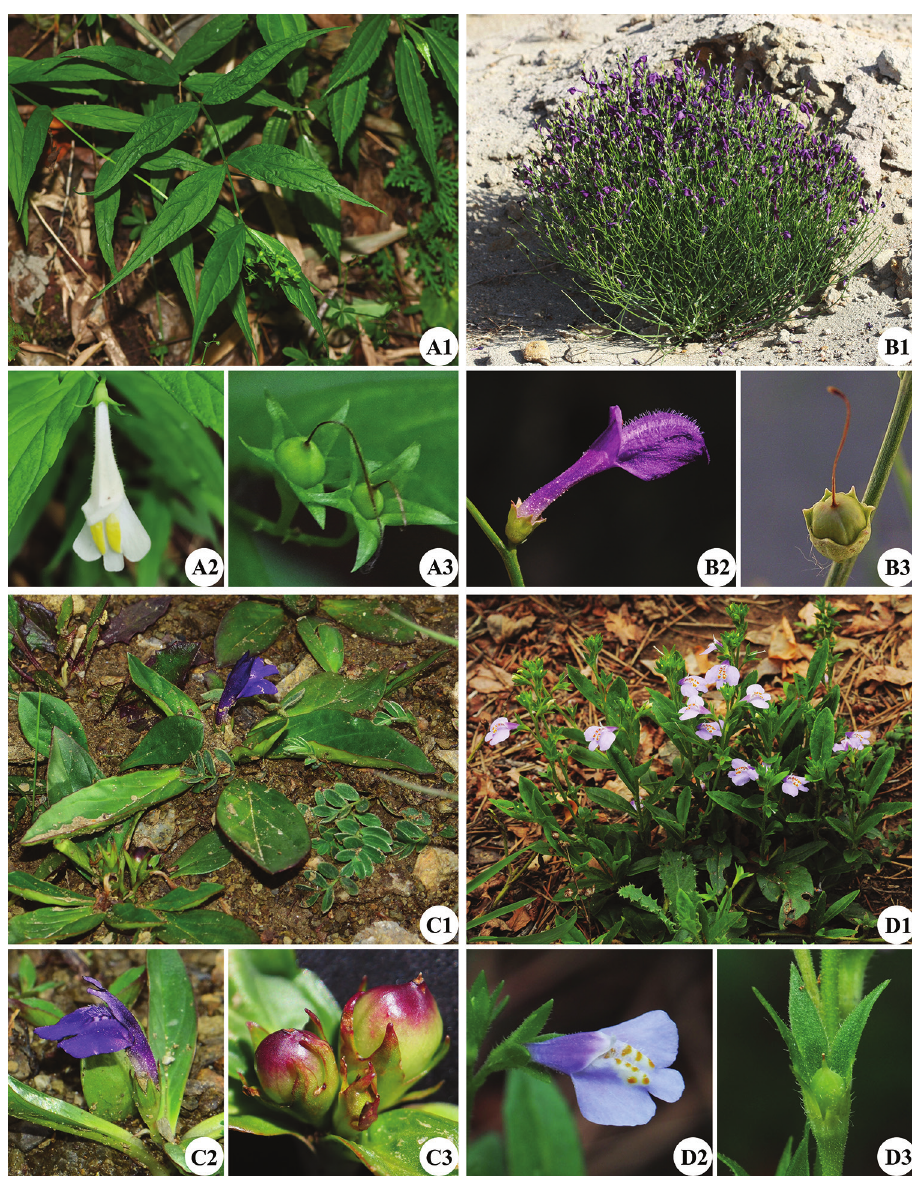
Figure 5. Morphological comparisons of the four genera of Mazaceae A Puchiumazus lanceifolius B Dodar- tia orientalis C Lancea tibetica D Mazus stachydifolius A1, B1, C1, D1 habits A2, B2, C2, D2 flowers A3, B3, C3, D3